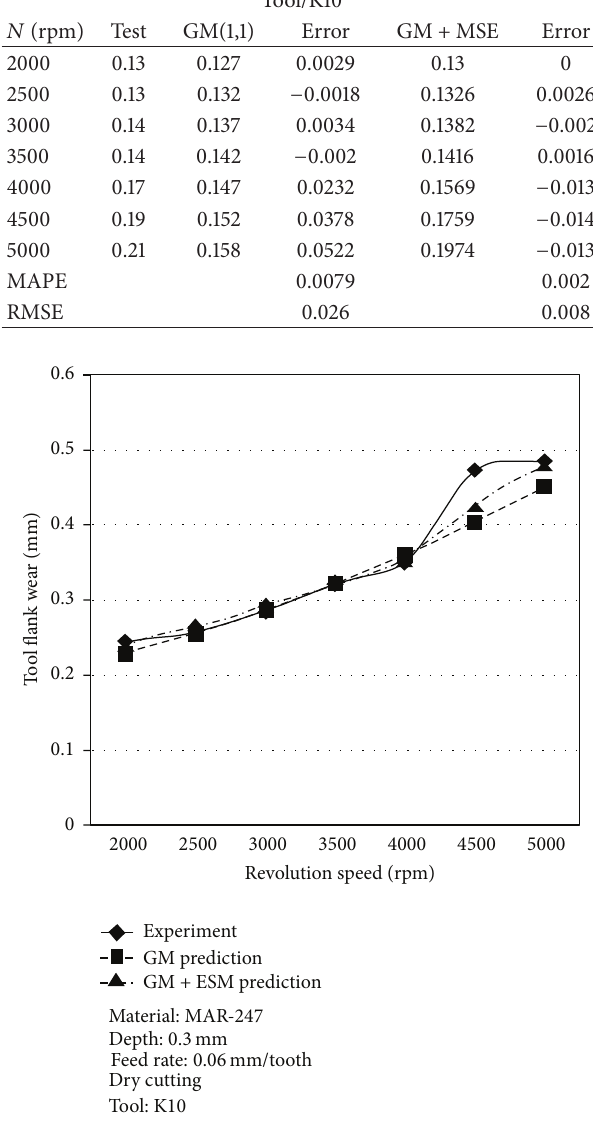
Figure 9: Relationships between revolution speed of main shaft and tool wear